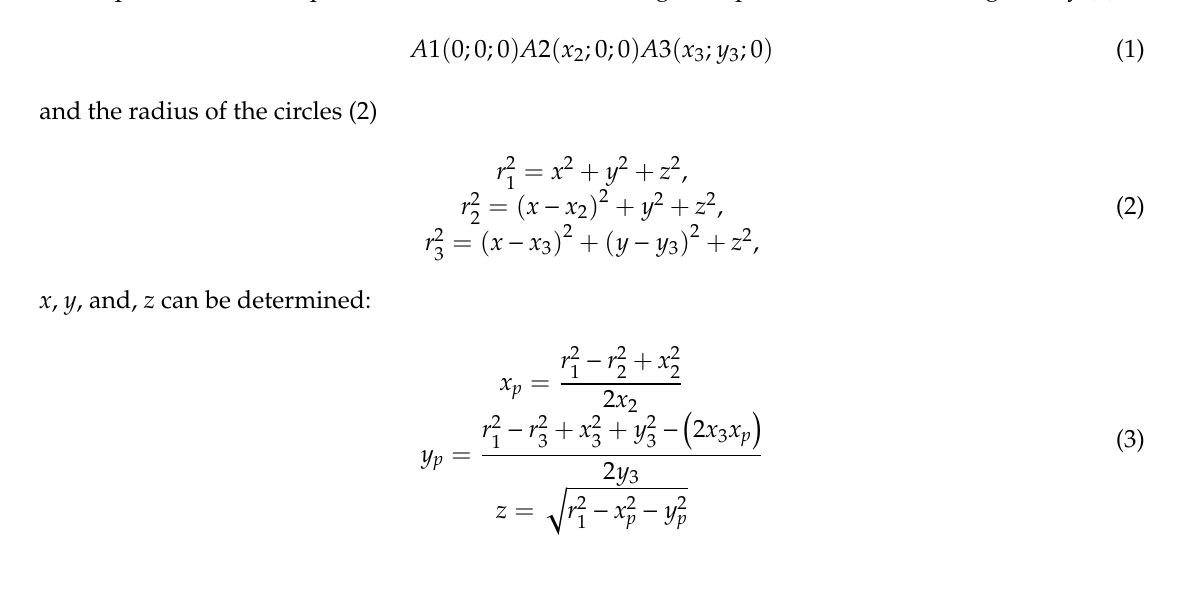
Figure 6. An example of trilateration.